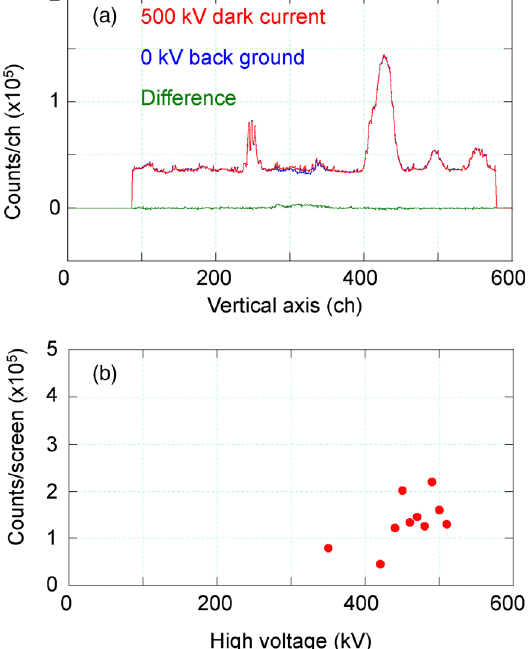
FIG. 13. (a) Dark current profile at 500 kV (red curve) measured on a YAG screen placed 1 m downstream from the photocathode and background profile at 0 kV (blue curve). The exposure time of the camera is 3 s. The green curve shows the difference of the blue curve and the red curve. (b) Areal sum of the green profile as a function of HV (red solid